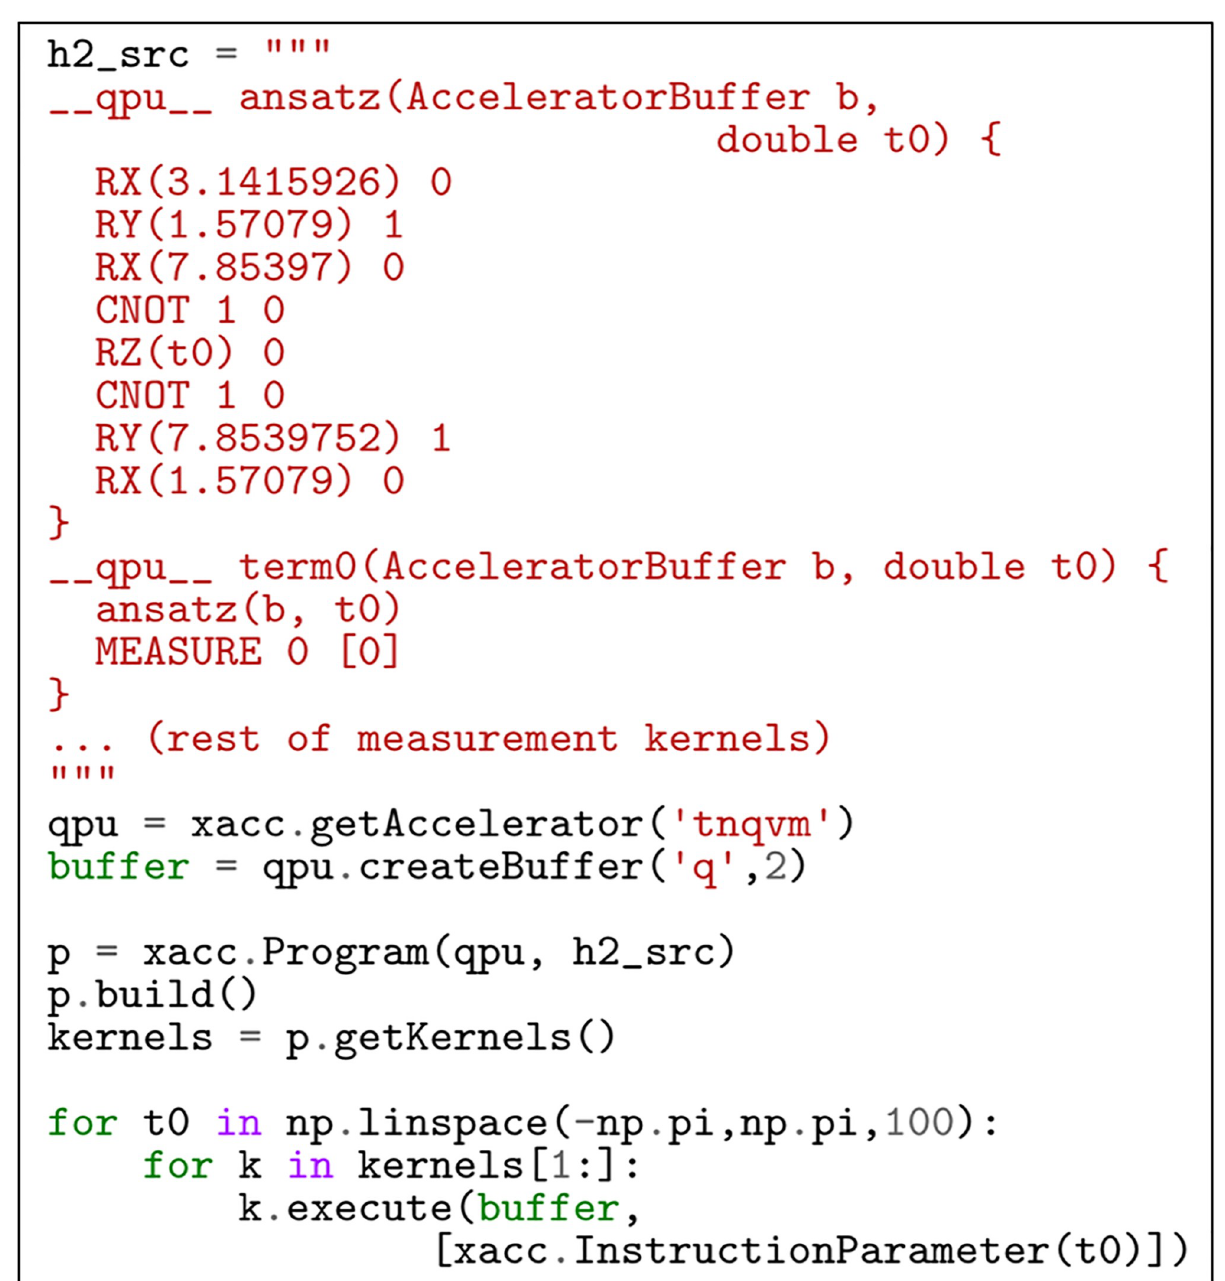
Fig 9. XACC program compiling and executing the variational quantum eigensolver for the H 2 molecule.